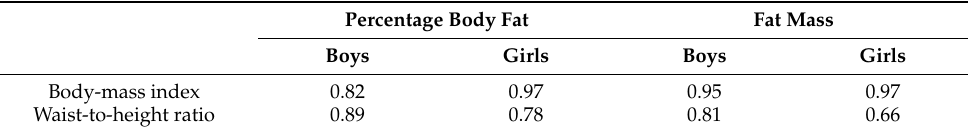
Table 4. Correlations between body-mass index, waist-to-height ratio, percentage body fat and fat mass using Spearman’s rank